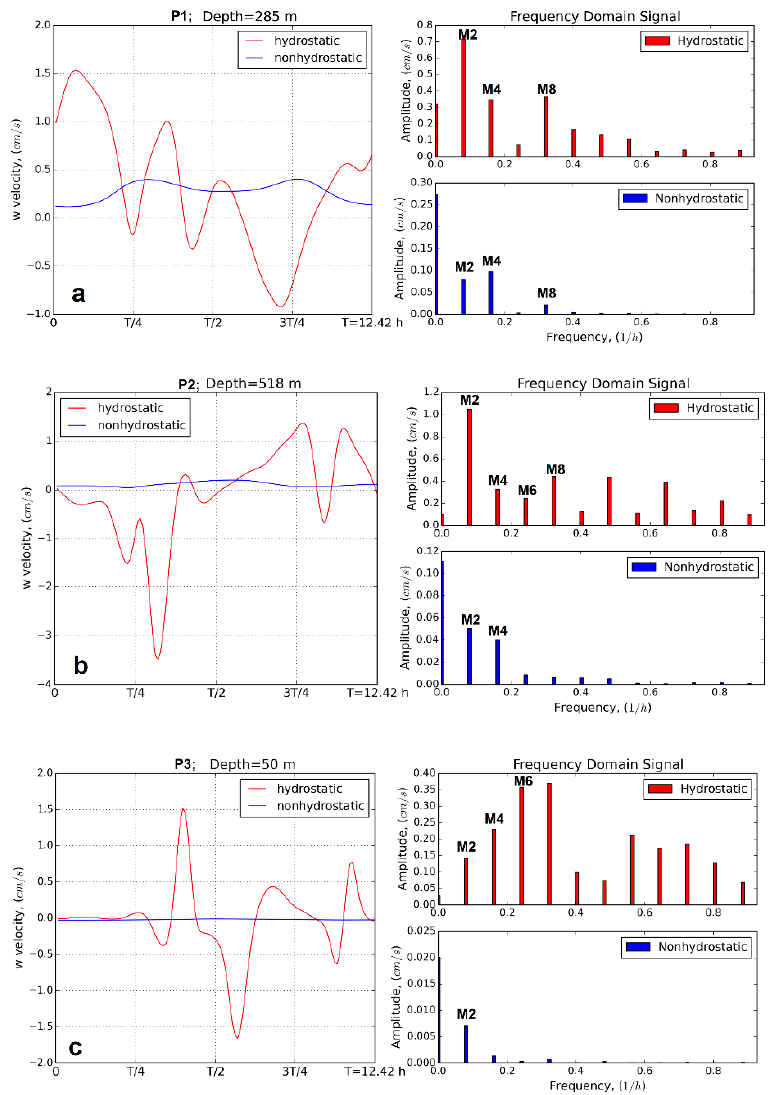
Figure 11. Left panel: comparison of the vertical velocity in the tidal cycle M 2 for Nh and Hs simulations; right panel: the spectra of vertical velocity at the points ( a ) P1; ( b ) P2; ( c ) P3 shown on the Figure 2a .